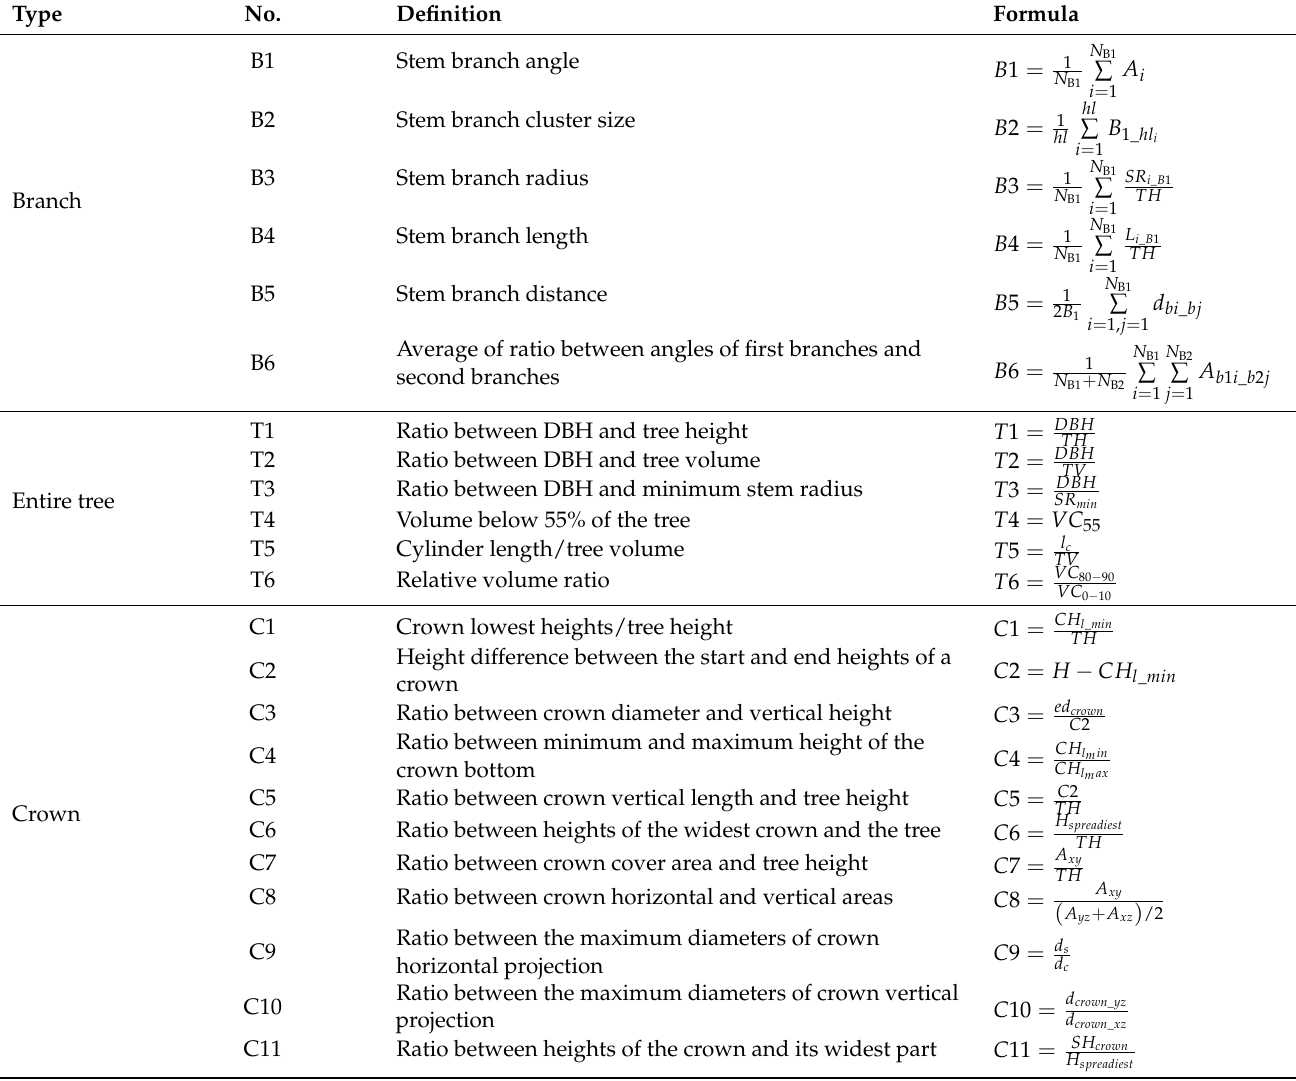
Table 2. The definition and formula of structural